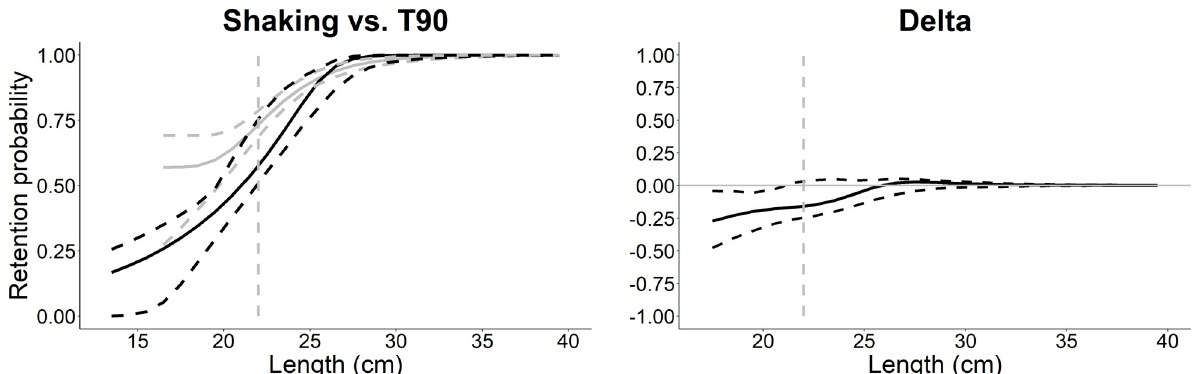
Fig 7. Selectivity comparison between the shaking and T90 codend. The left plot compares the size selectivity curves of the shaking codend versus the T90 codend: black and grey lines are the selection curves for the shaking codend and T90 codend, respectively; black and grey dashed lines are the 95% Efron percentile confidence intervals for the shaking and T90 codend, respectively. The right plot illustrates the delta curve: black line is the delta curve; grey dashed lines are the 95% Efron percentile confidence intervals. The vertical grey dashed lines in both plots represent the minimum landing size (MLS) for Canadian redfish fishery.